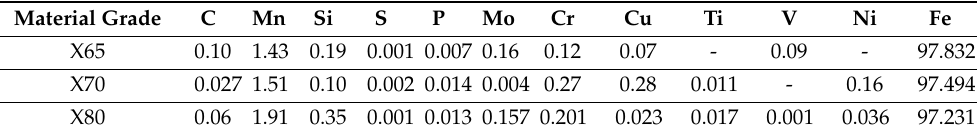
Table 1. Chemical compositions of API 5L X65, X70 and X80 pipeline steel (wt.%). [14,33]. Reprinted with permission from [14,33], 2008, 2019, Elsevier.